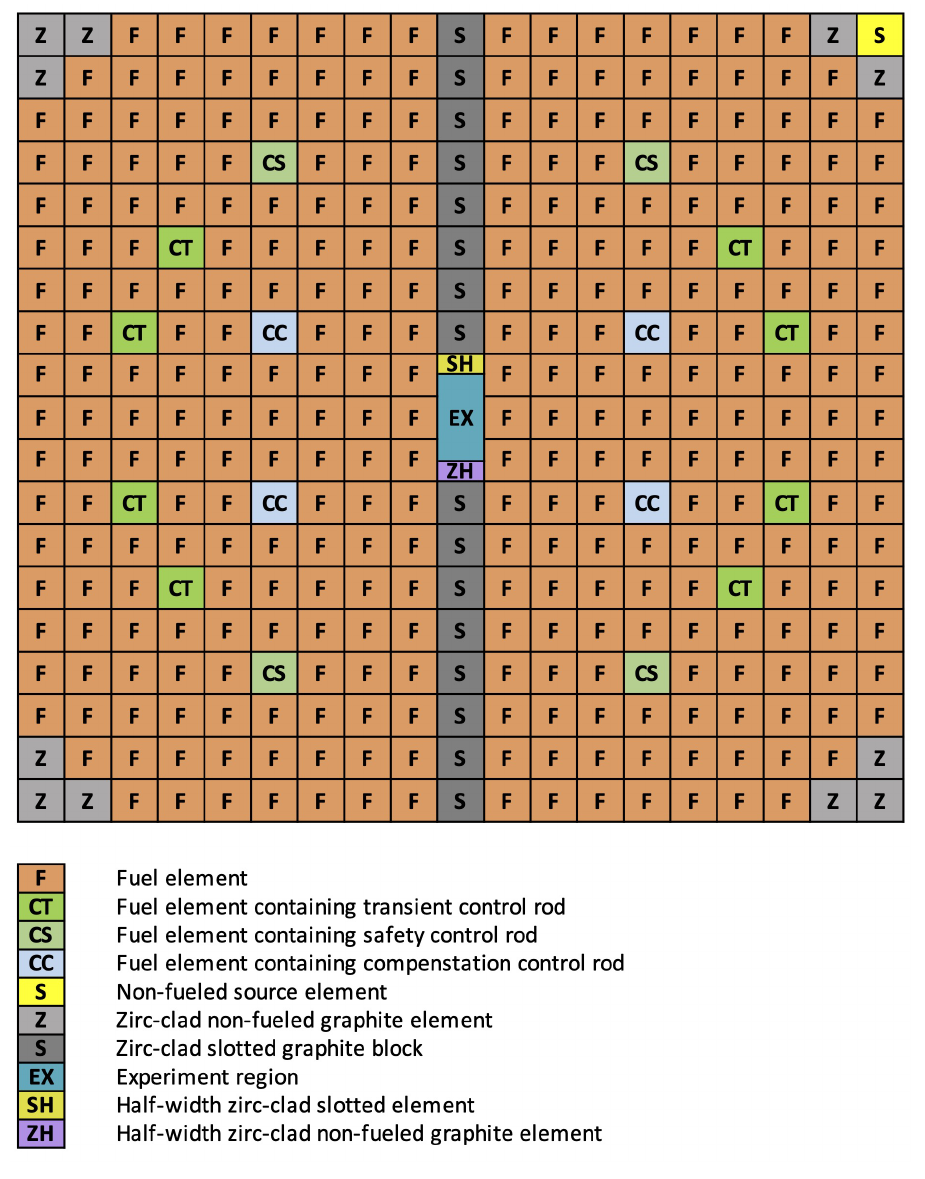
Figure 3. SIRIUS-CAL core configuration, showing control rod